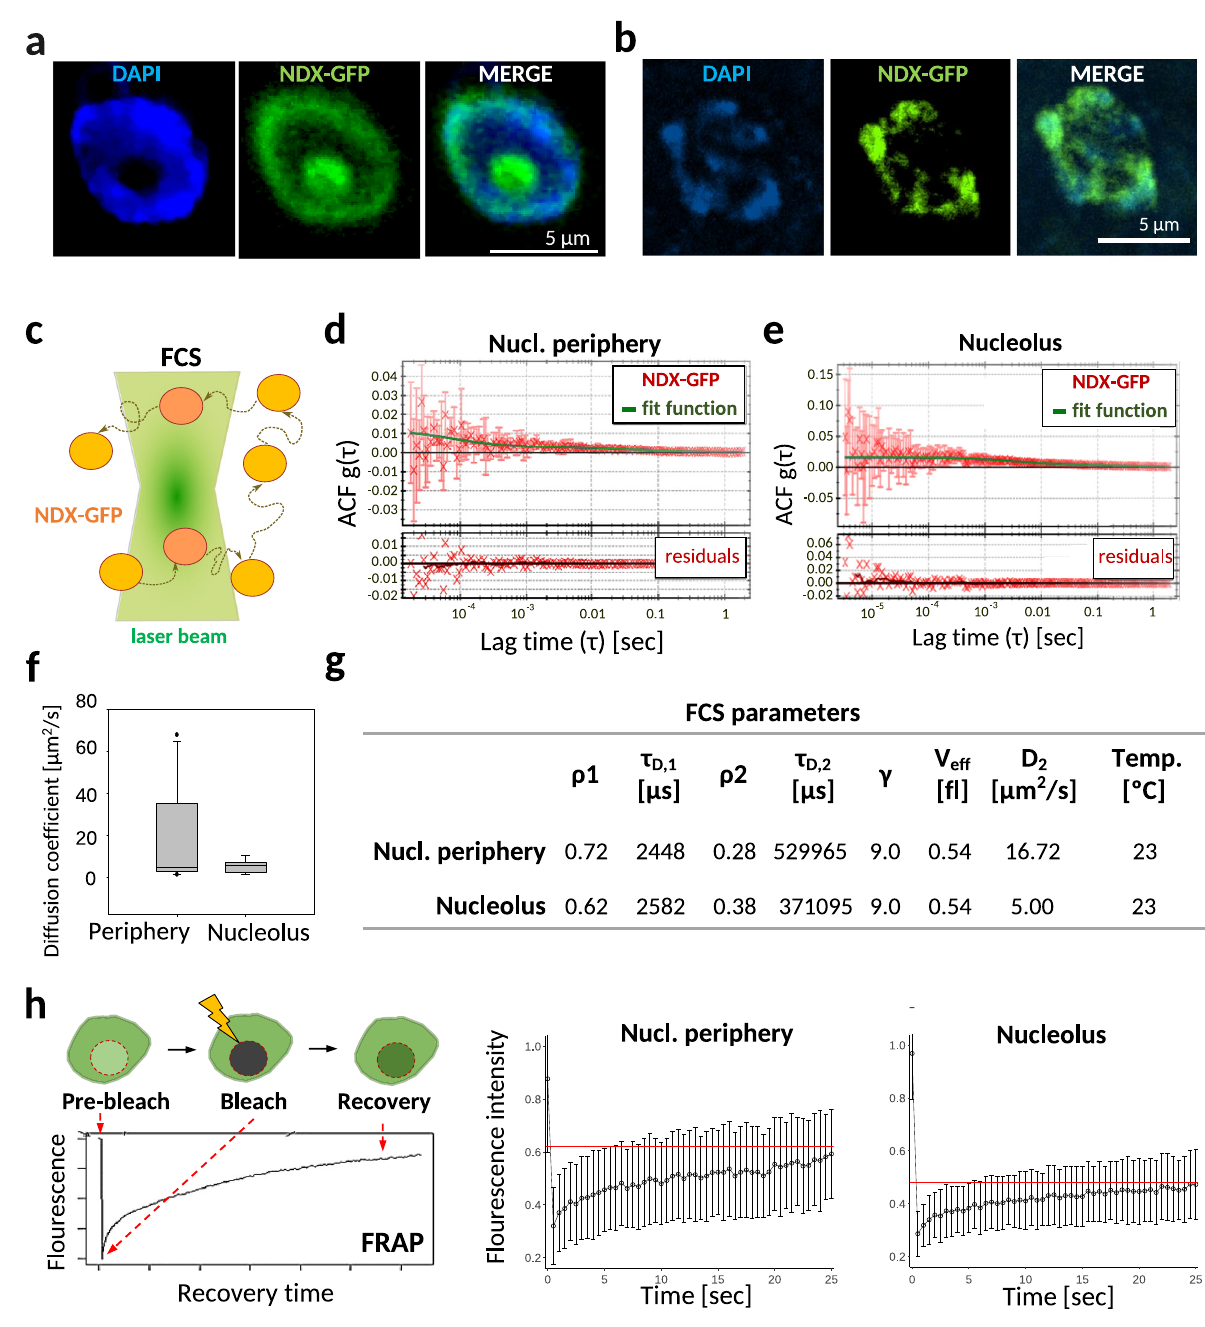
Fig.2|MicroscopiclocalizationandmoleculardiffusionofNDXinArabidopsis root tips. a , b Representative confocal images showing the pattern of NDX-GFP distributioninDAPIstainednuclei.Theexperimentswererepeatedfourtimeswith similar results. a The GFP signal is enriched in the nuclear periphery and in the central (DAPI-negative) region, corresponding to the nucleolus. Nucleolar staining is detected in 5 – 20% ofcells. b A minor fraction of cells with typical chromocenter structure (DAPI foci) shows strong NDX-GFP enrichment at chromocenters. c Scheme of fl uorescence correlation spectroscopy (FCS) measurement. d , e Representative time-dependent autocorrelation functions (ACFs) with the estimateddiffusionparametersandresiduals.ACFcurvesrepresentthecorrelation coef fi cient between the fl uctuation from the mean GFP fl uorescence intensity at time I(0) and the fl uctuation from the mean intensity at some time later I(t). The curves were fi tted with a two-component 3D normal diffusion model. Sample size n =16individualcellsexaminedoverthreeindependentexperiments. f Distribution